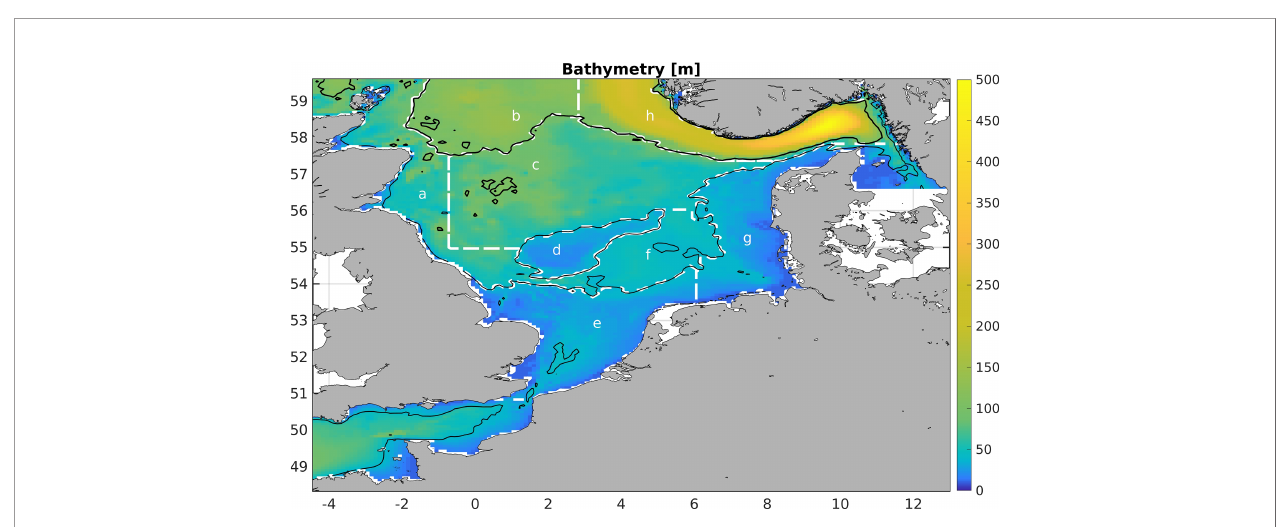
FIGURE 1 | Model bathymetry. The thin and thick black contour lines are the 40 m and 100 m isobaths, respectively. The white dashed lines de fi ne the boxes over which we average (see Section Methods of Analysis